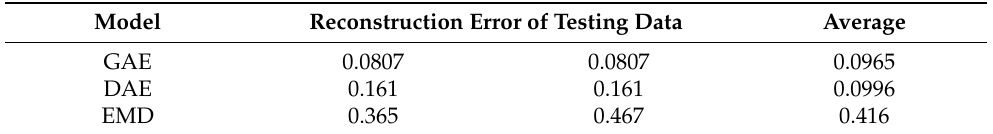
Figure 14. Comparison of reconstruction accuracy of three noise reduction models. Tables 11 and 12 show that the MAE error of GAE training data is (0.0864 − 0.0747)/ 0.0864 × 100% = 13.54% lower than that of DAE and 78.72% lower than that of EMD; the MAE error of GAE test data is 3.11% lower than that of DAE and 76.80% lower than that of EMD. Table 11. Reconstruction errors of training data. Table 12. Reconstruction errors of testing